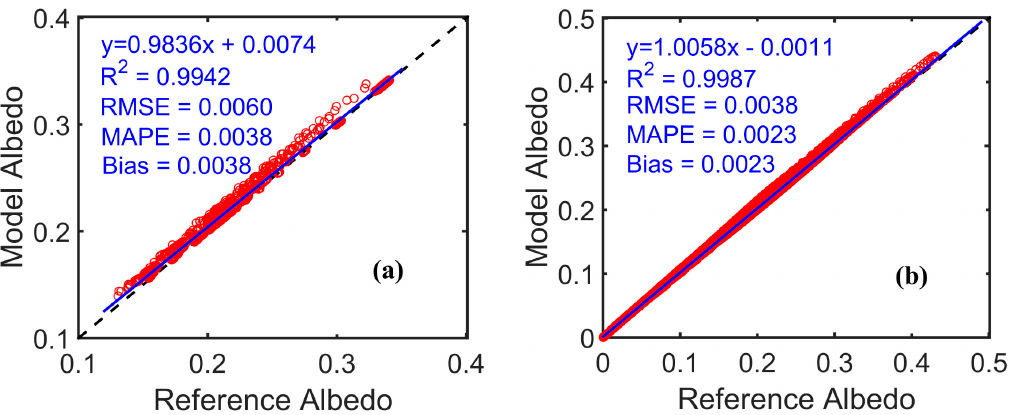
Figure 5. Scatterplots between the reference and the modeled BSAs over ( a ) simulated DEMs and ( b ) real